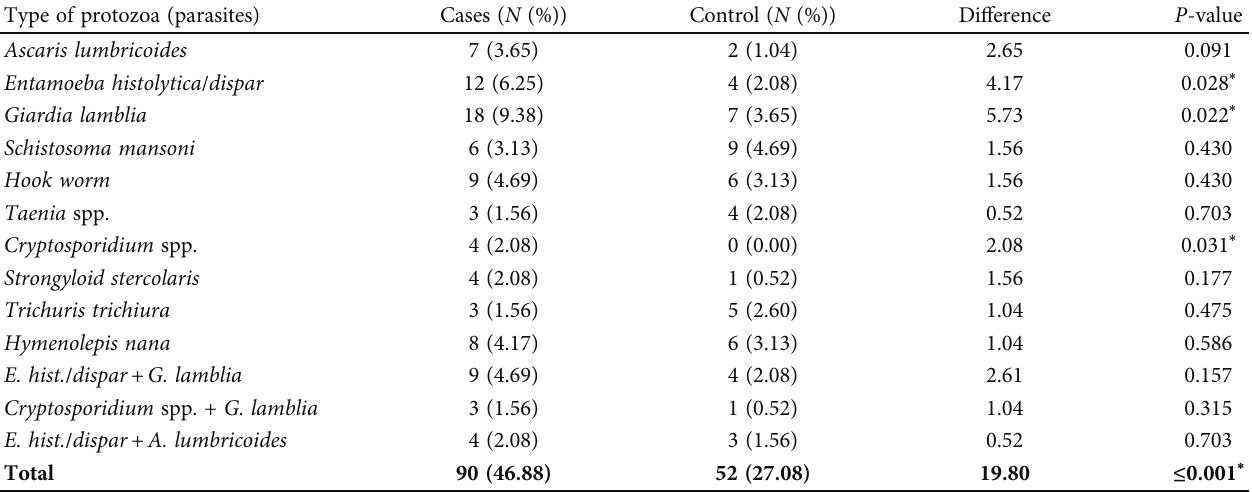
Table 2: Prevalence of intestinal protozoan and parasites in cases ( N = 192 ) and control ( N = 192 ) among individuals visiting Negelle Borena General